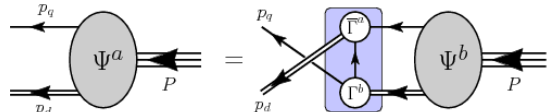
Figure 1. Poincaré covariant Faddeev equation: a linear inte- gral equation for the matrix-valued function Ψ , being the Fad- deev amplitude for a baryon of total momentum P = p q + p d , which expresses the relative momentum correlation between the dressed-quarks and -diquarks within the baryon. The shaded rectangle demarcates the kernel of the Faddeev equation: single line , dressed-quark propagator; Γ , diquark correlation amplitude; and double line , diquark propagator.